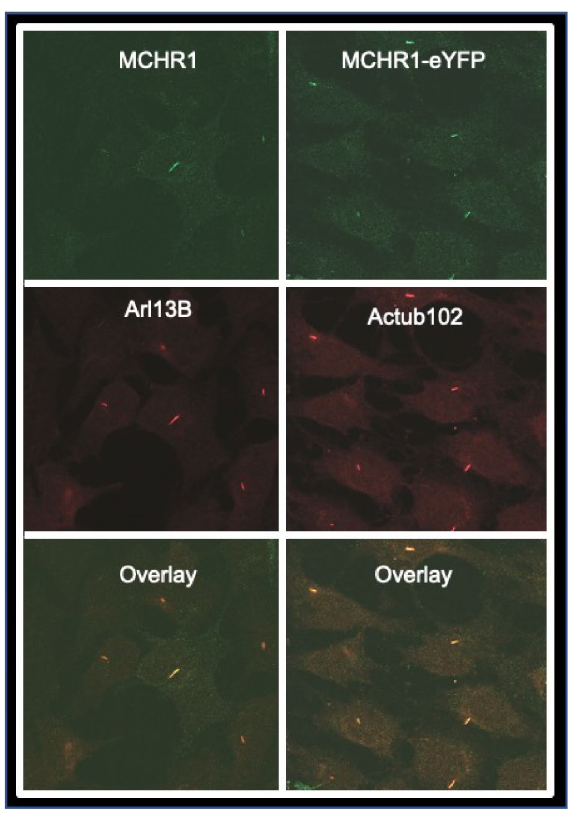
Figure 2. Co-localization of MCH receptor 1 (MCHR1) with ciliary markers. 3T3-L1 cell adipogenesis was initiated with differentiation media for 2 days. Left panels: Endogenous MCHR1 was detected using anti- MCHR1 antibody. Arl13B-antibody was used to label primary cilia. Right panels: MCHR1-eYFP was transiently transfected into cells prior to differentiation treatment. Anti-Actub102 was used as a ciliary marker. The Overlay panels illustrate